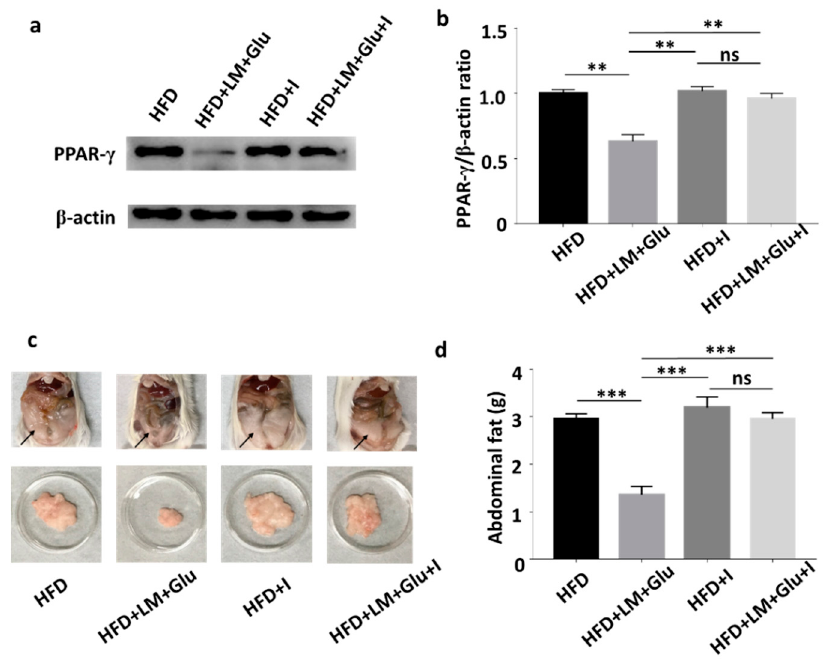
Figure 4. Involvement of Ffar2 in the action of L. mesenteroides EH-1 on the HFD-induced upregulation of PPAR- γ . HFD-fed mice were orally administered with or without L. mesenteroides EH-1 (LM) plus 2% glucose (Glu) right after administration of GLPG-0974, a Ffar2 antagonist (I), every 3 days for 25 days. ( a ) The levels of PPAR- γ and β -actin in abdominal fat depots were detected by western blot analysis. ( b ) The ratio intensities of PPAR- γ to β -actin were quantified. ( c ) Representative mice with abdominal fats (arrows) in the whole body or isolated abdominal fat depots were shown. ( d ) Abdominal fat depots HFD-fed mice administered with L. mesenteroides EH-1 with glucose in the presence (2.957 ± 0.076 g, n = 5) or absence (1.358 ± 0.102 g, n = 5) GLPG-0974 for 25 days were dissected and weighted. Data shown represent the mean ± SD of experiments performed in triplicate and five replicates. ** p < 0.01; *** p < 0.001. ns = nonsignificant. Bars = 10 mm.